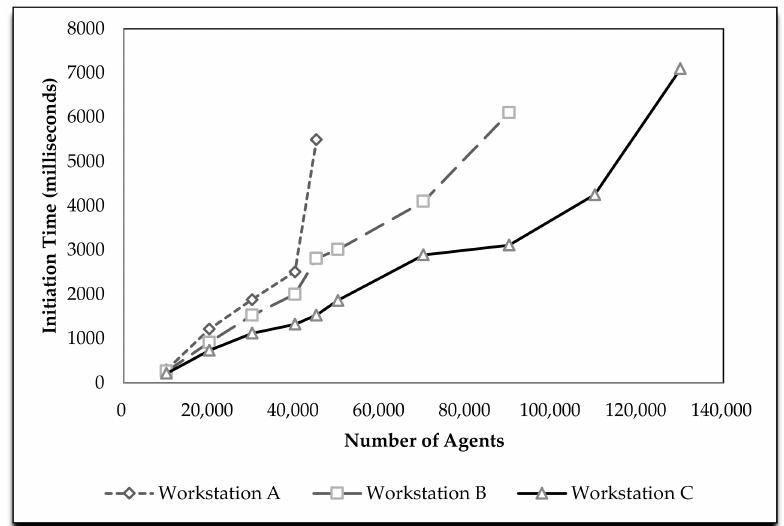
Figure 8. Number of software agents initiated on three distinct